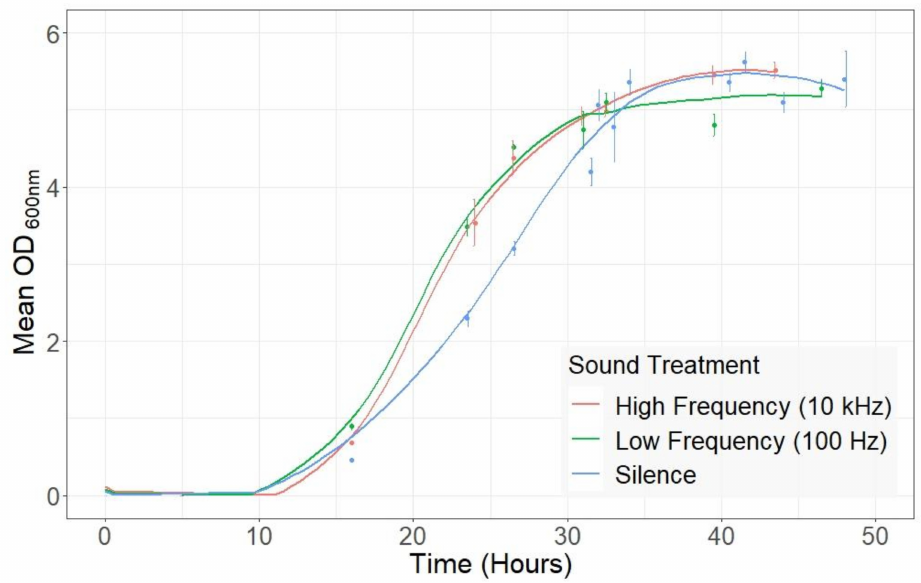
Figure 1. Growth curves of Saccharomyces cerevisiae exposed to different sound conditions. Two growth experiments under control silence conditions were averaged, shown in blue. Growth curves exposed to high-frequency sound of 10 kHz (red) and low-frequency sound of 100 Hz (green) are presented. Plotted values are means of biological replicates (n = 3) from each time point and error bars ( ± Standard